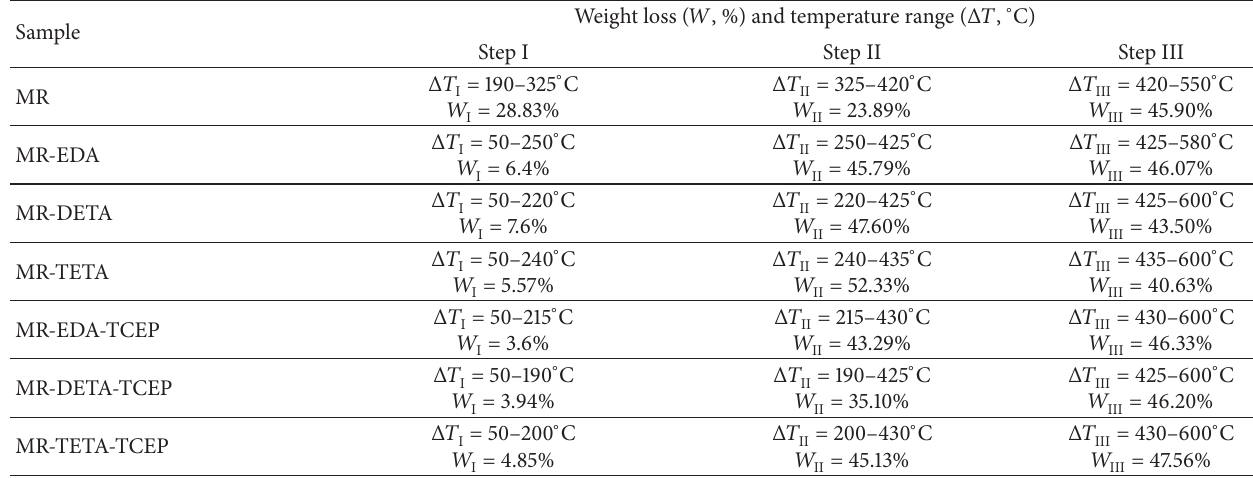
Table 2: TGA data for Merrifield resin and its substituted derivatives.